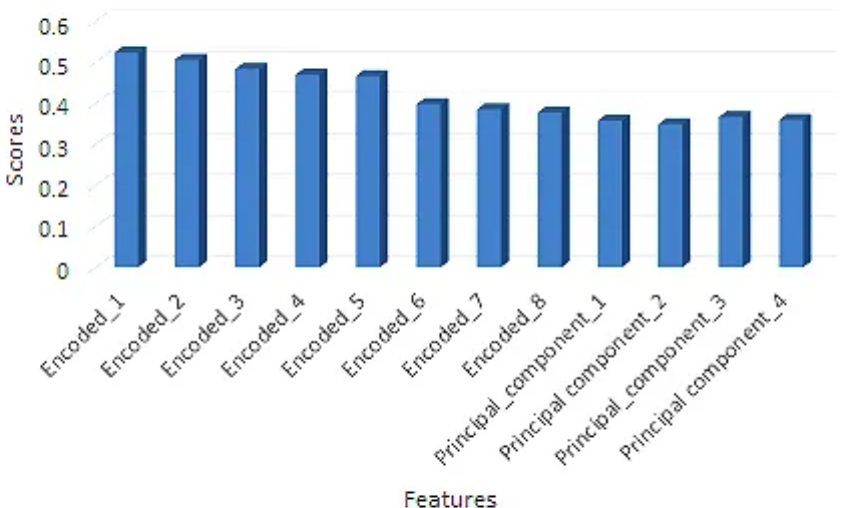
Figure 12. The DSAE and PCA feature importance validation using mutual information